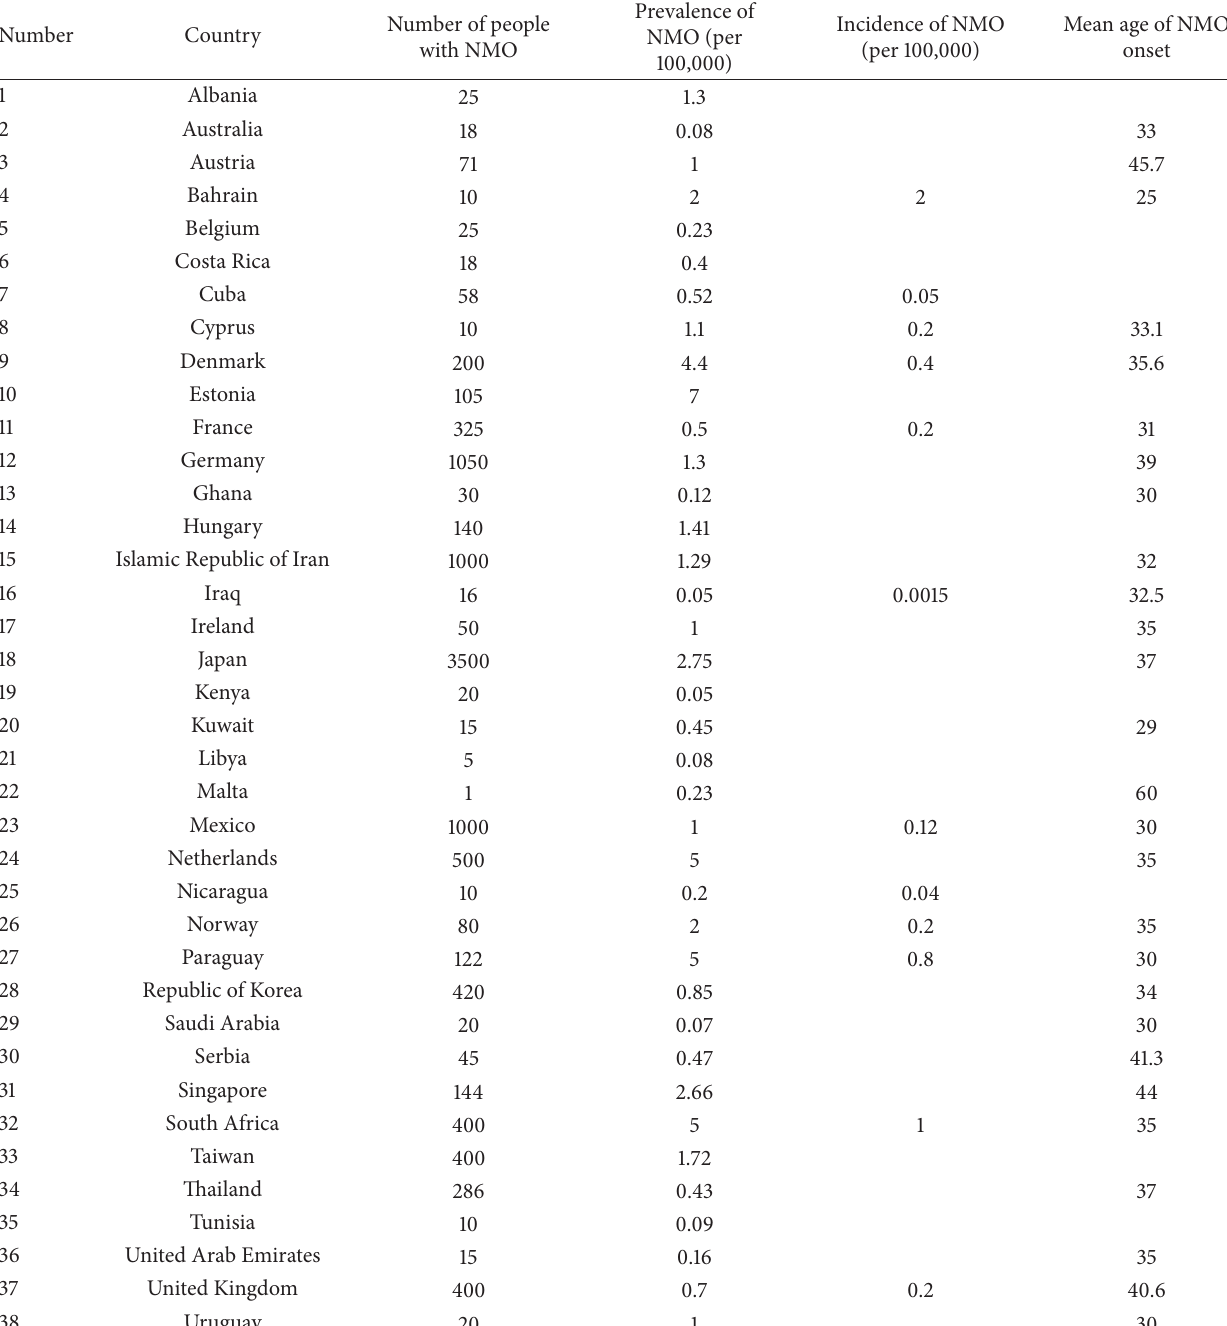
Table 4: Prevalence of Neuromyelitis optica globally (data gathered from query data of Multiple Sclerosis International Federation